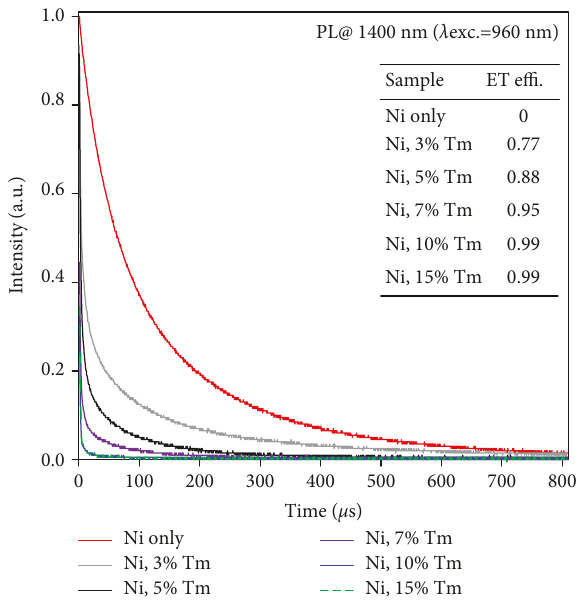
Figure 5: Time decay pro fi les of Ni 2+ emissions at 1400 nm ( ± 25nm) for the CaTi O :0.2 mol% Ni codoped with various 0.9 3 concentrations of Tm 3+ excited at 960 nm (Ni 2+